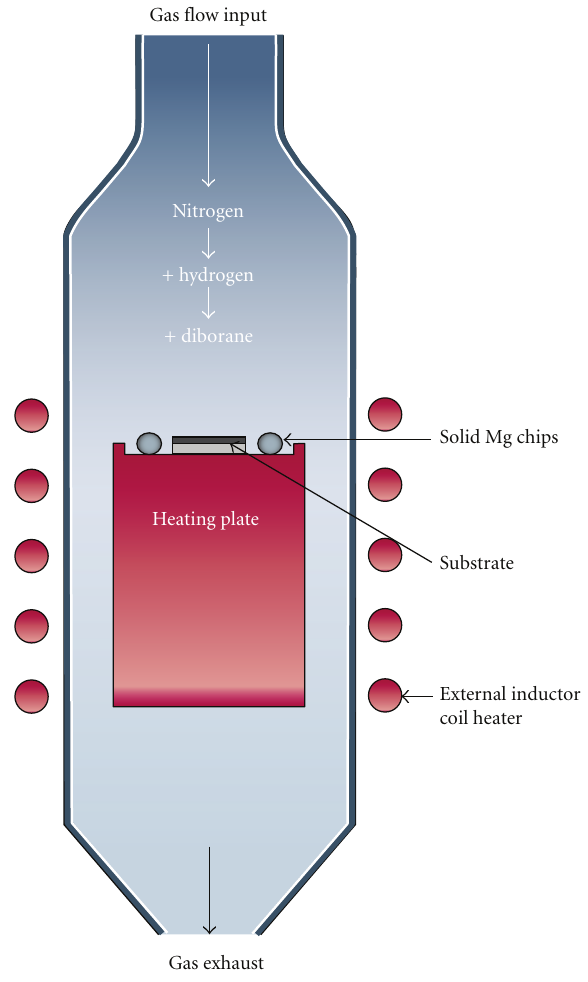
Figure 3: (From [22]): Schematic of the hybrid physical-chemical vapor deposition technique for growing epitaxial MgB 2 films. Vaporized Mg reacts with B from the flowing diborane gas, and an MgB 2 film condenses onto the substrate. c